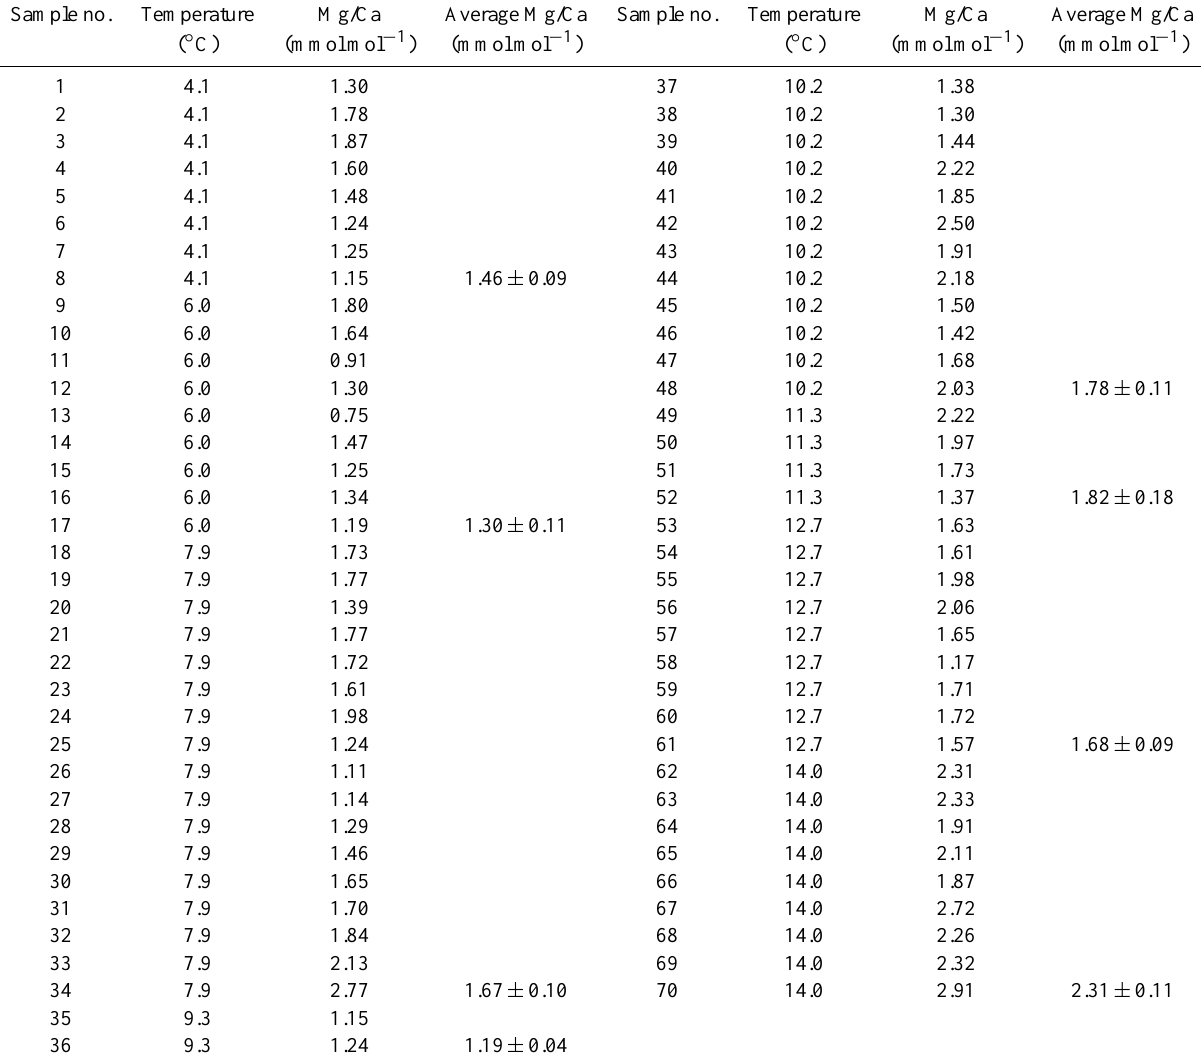
Table 2. Sample number with single specimen Mg/Ca value for B. marginata . Mg/Ca values for individual foraminifers are based on 1–4 laser ablation profiles. The error in averaged Mg/Ca values per temperature experiment is based on the standard error of the average ( σ / Sample